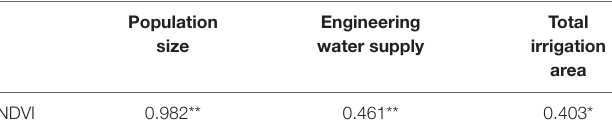
TABLE 2 | Correlation between NDVI and human factors in Alxa League from 2000 to 2019.